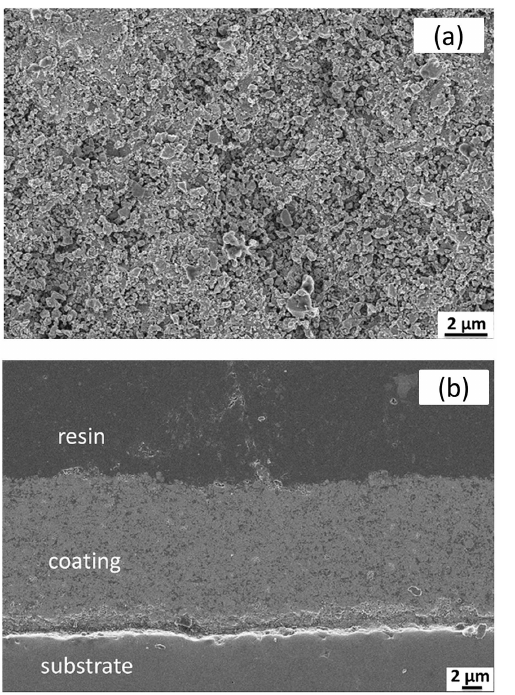
Figure 3. SEM images of ADM-coated BFT30 sensor (a) top view, (b) cross-section